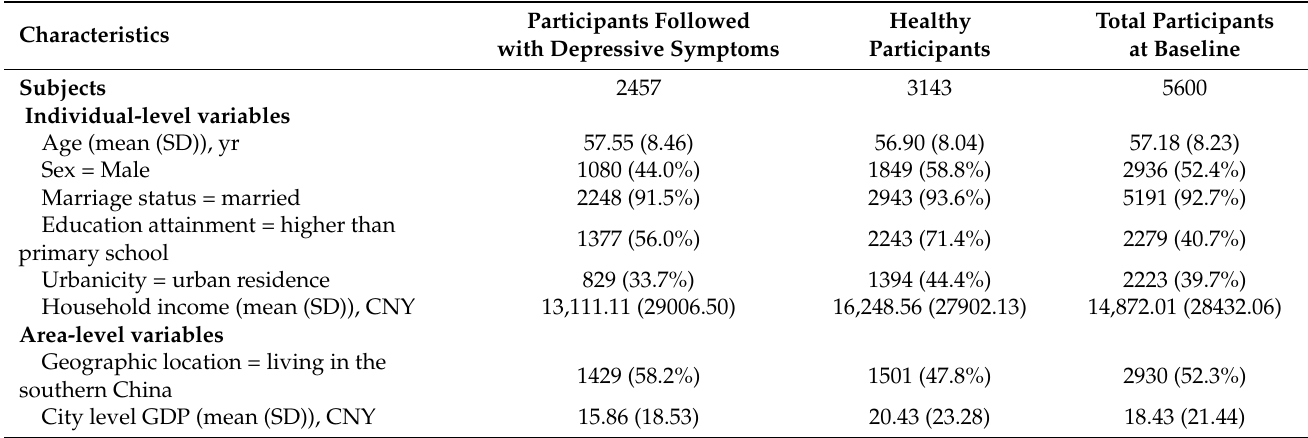
Table 1. Summary statistics of the participants’ baseline